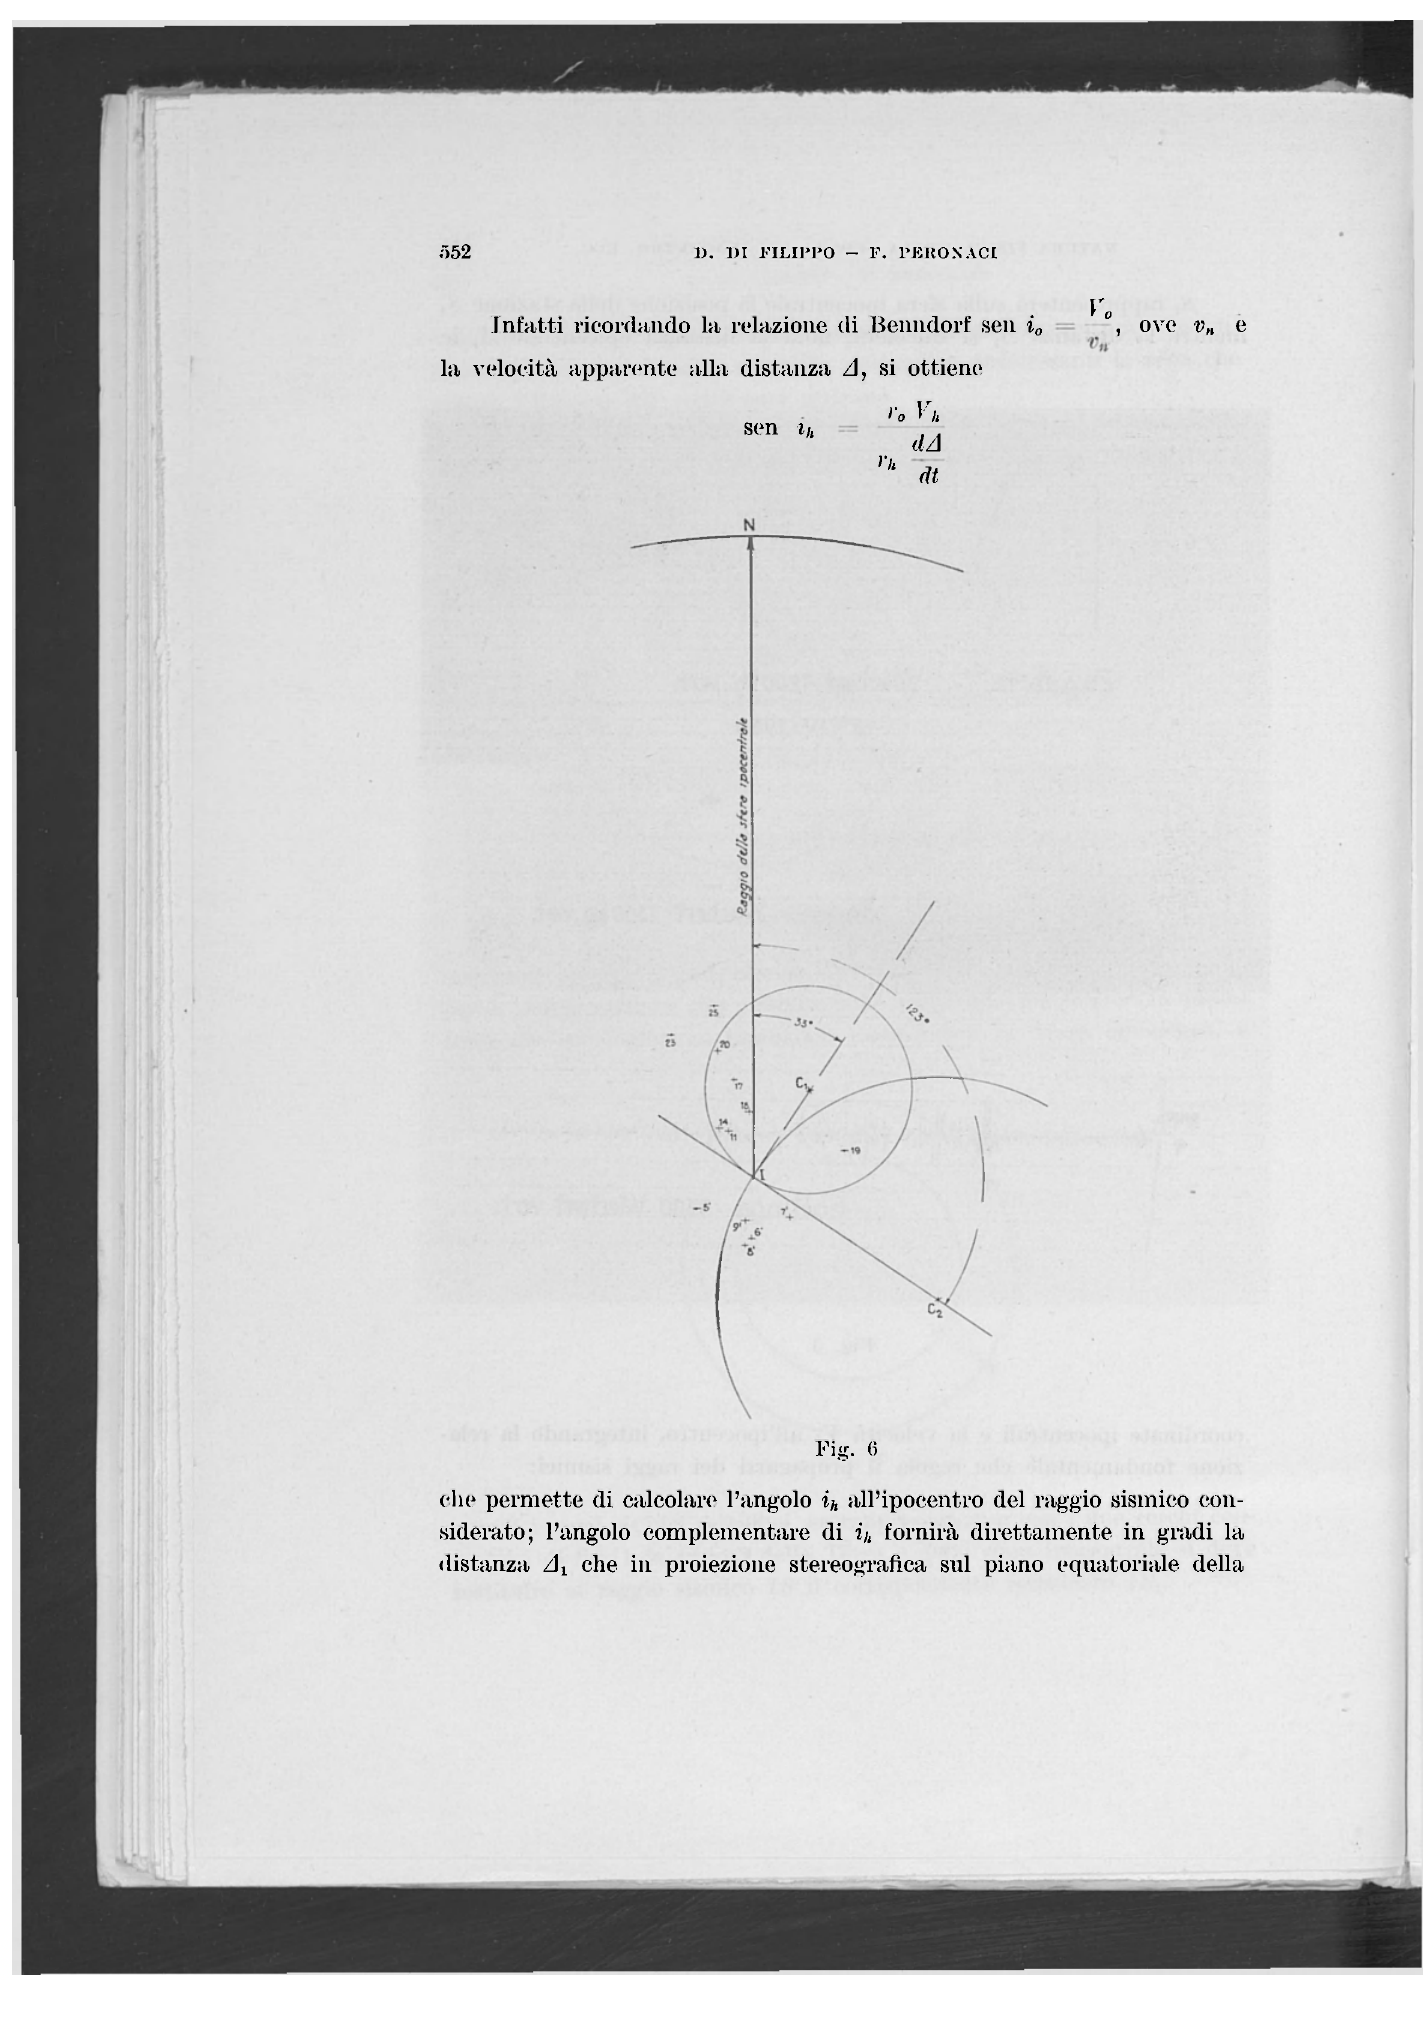
che permette di calcolare l'angolo i all'ipocentro del raggio sismico con- h siderato; l'angolo complementare di ih fornirà direttamente in gradi la distanza A che in proiezione stereografica sul piano equatoriale 1